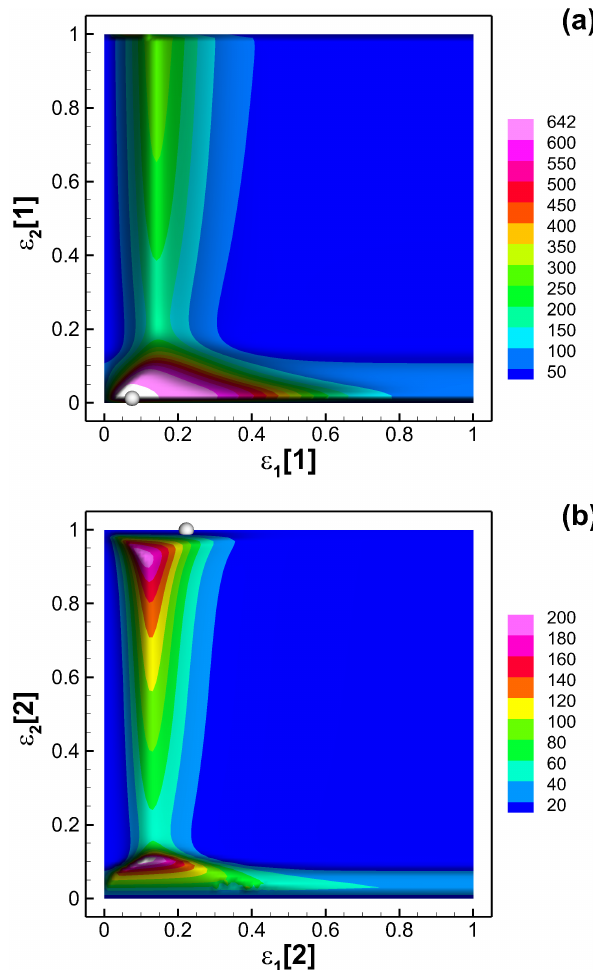
Fig. 7. Internal entropy production in (a) box [1], Eq. (14) as a function ε 1 and ε 2 in box [1] for a fixed value of ε 1 and ε 2 in box [2] of 0.2222 and 0.9998, respectively, and (b) in box [2], Eq. (15), as a function ε 1 and ε 2 in box [2] for a fixed value of ε 1 and ε 2 in box [1] of 0.0754 and 0.0123, respecitvely. White point in (a) and (b) dentotes the position of the global MEP solution in boxes [1] and [2] based on Eq. (19) (Table